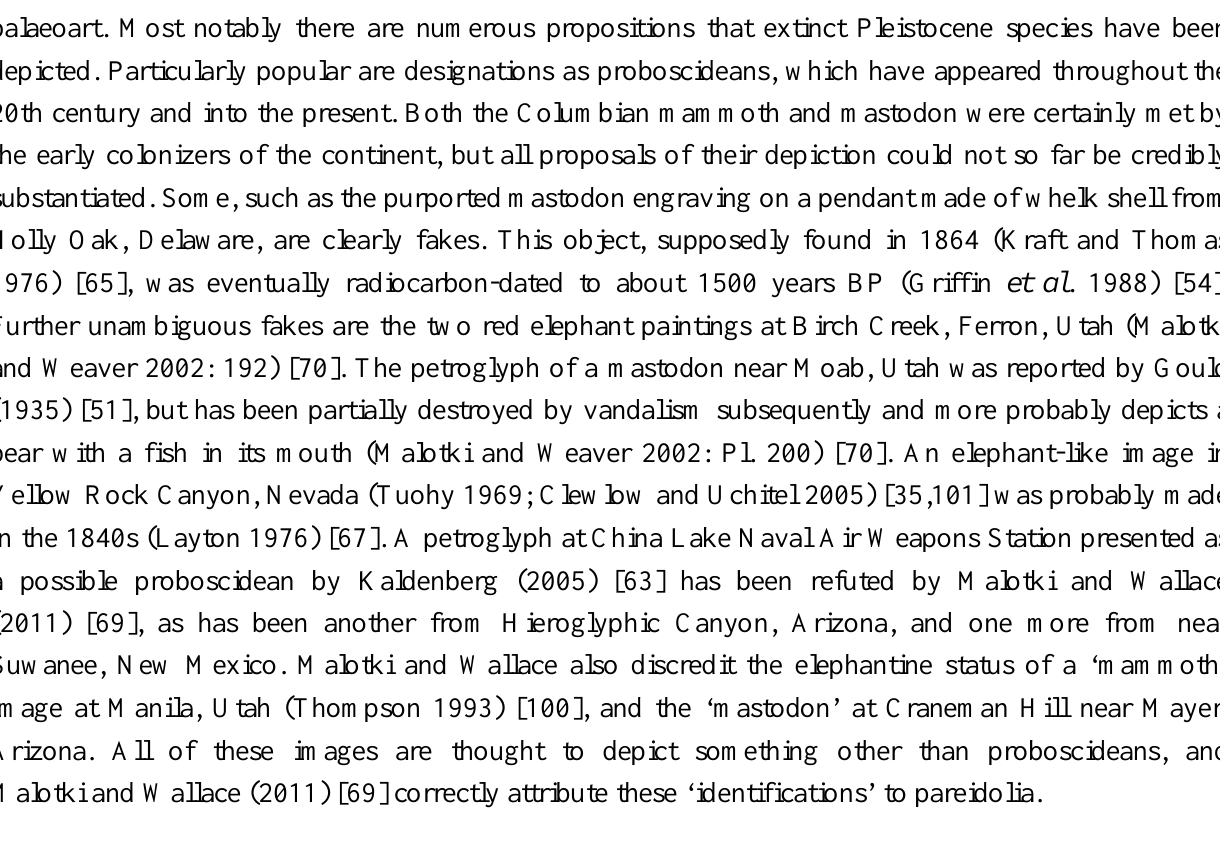
Figure 1. Petroglyph arrangement of unrelated elements on cliff at Upper Sand Island, Bluff Utah, thought to depict a mammoth, but less than 4000 years